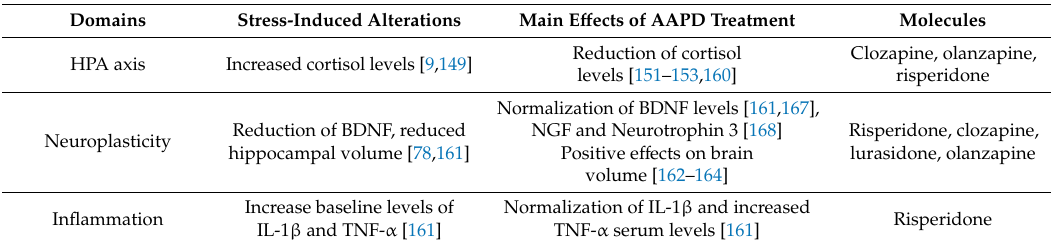
Table 2. Main stress-induced alterations observed in schizophrenic patients and their modulations following AAPD